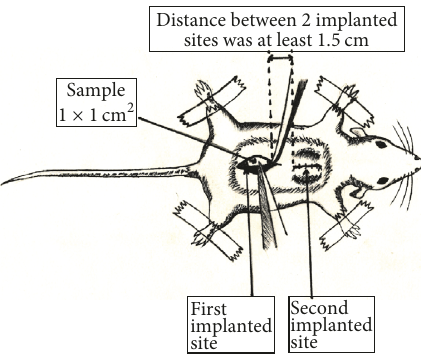
Figure 1: Cartoon depicting surgical model for subcutaneous implant